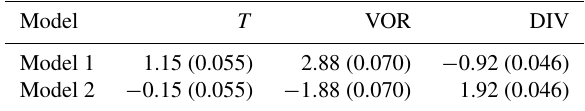
Table 4. Weights for the supermodel trained by CPT and the synch rule. The standard deviation over the year (CPT) or the standard deviation over the last 10 weeks of training (synch rule) is given in parentheses. The weights are only given for model 1, for model 2 the weight equals 1 − weight of model 1.